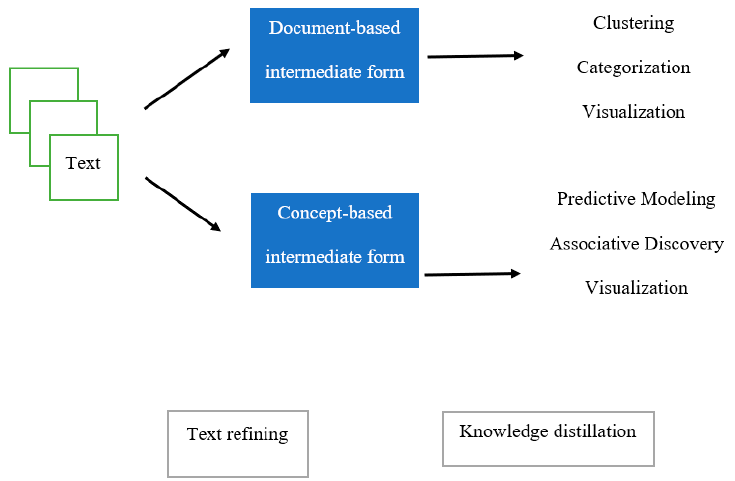
Figure 1. The framework of text mining.